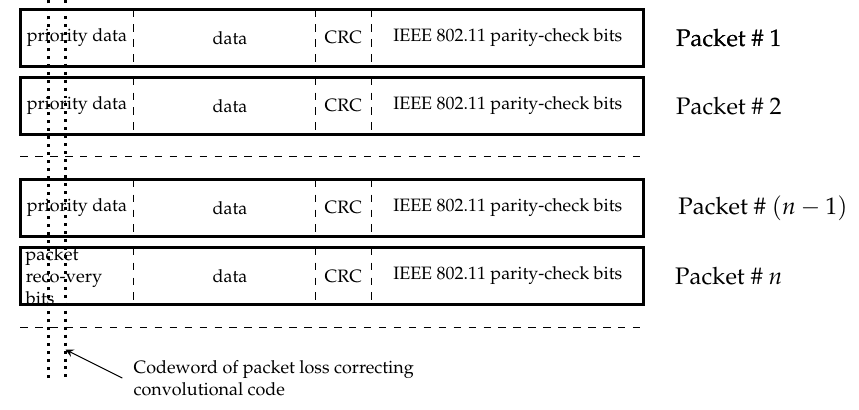
Figure 2. Coding for recovering packet